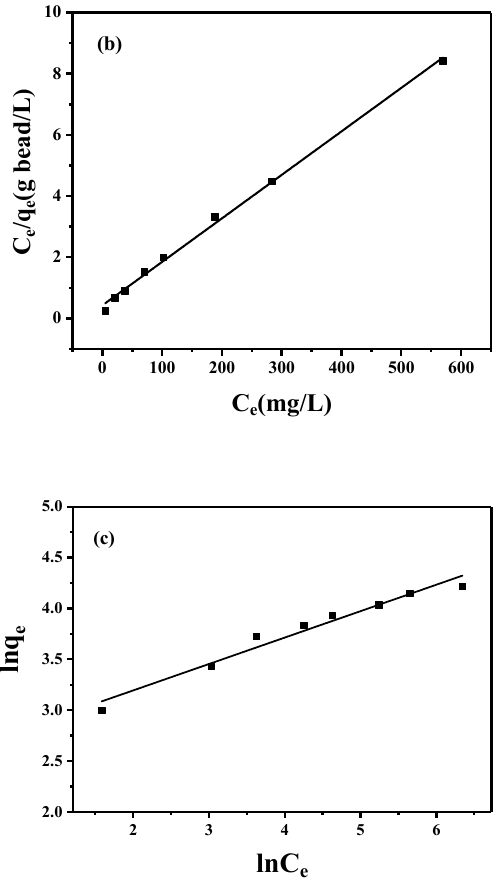
Figure 4. Adsorption isotherms of lead onto peptide bead: ( a ) nonlinear fitting by Langmuir and Freundlich isotherms; ( b ) linear Langmuir isotherm; and ( c ) linear Freundlich isotherm.